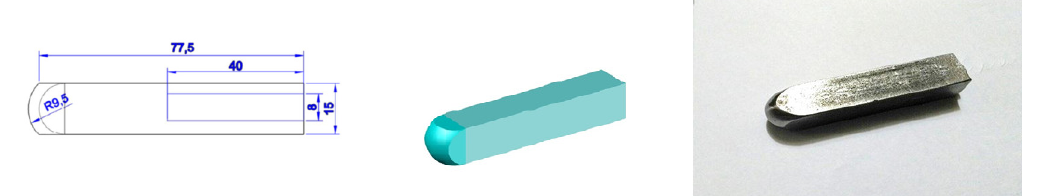
Fig. 7. Dimension of punch that used in this